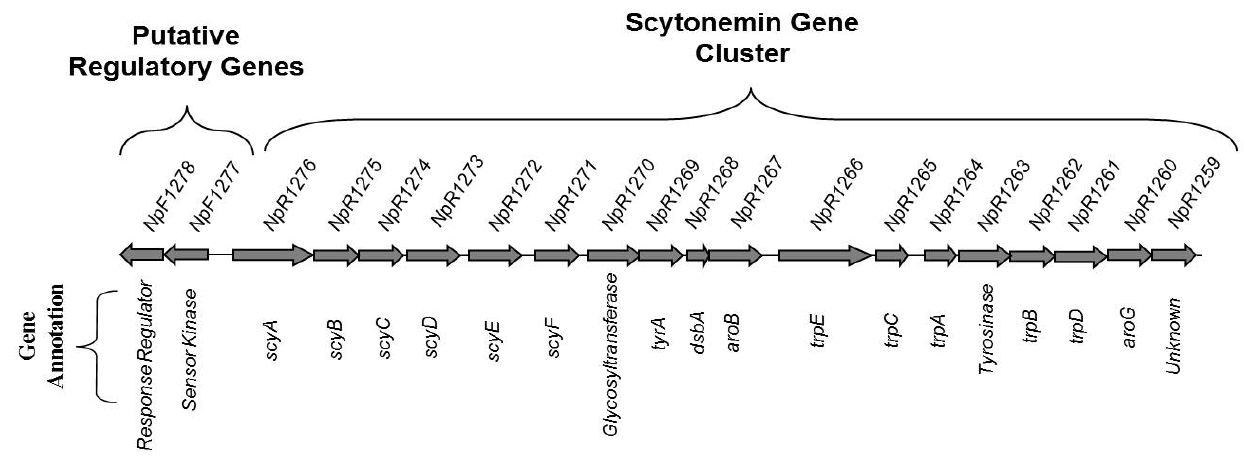
Figure 1. Main scytonemin biosynthetic gene cluster and regulatory genes in the N. punctiforme genome.